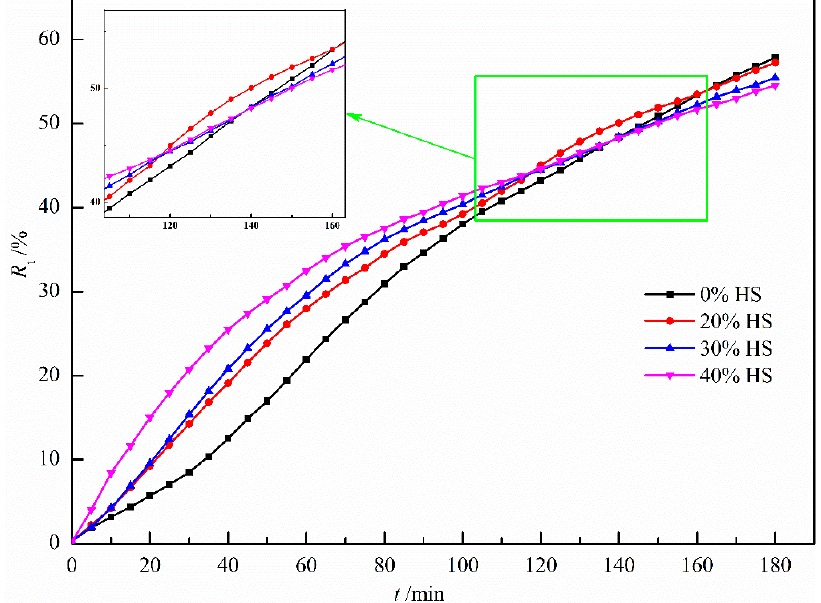
Figure 13. The degree of reduction at different reduced time.